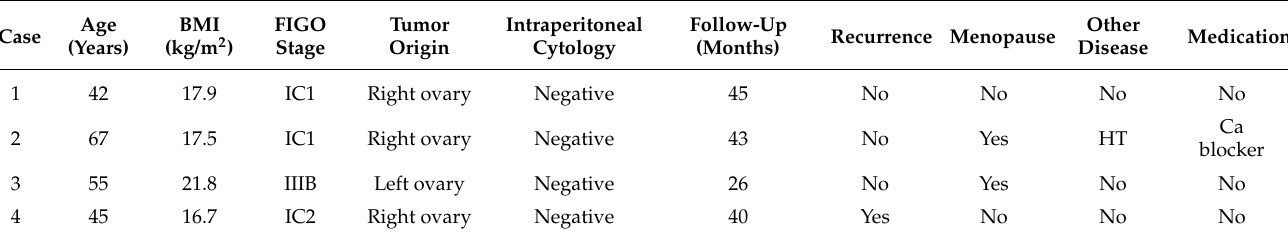
Table 3. Characteristics of four patients with ovarian clear cell